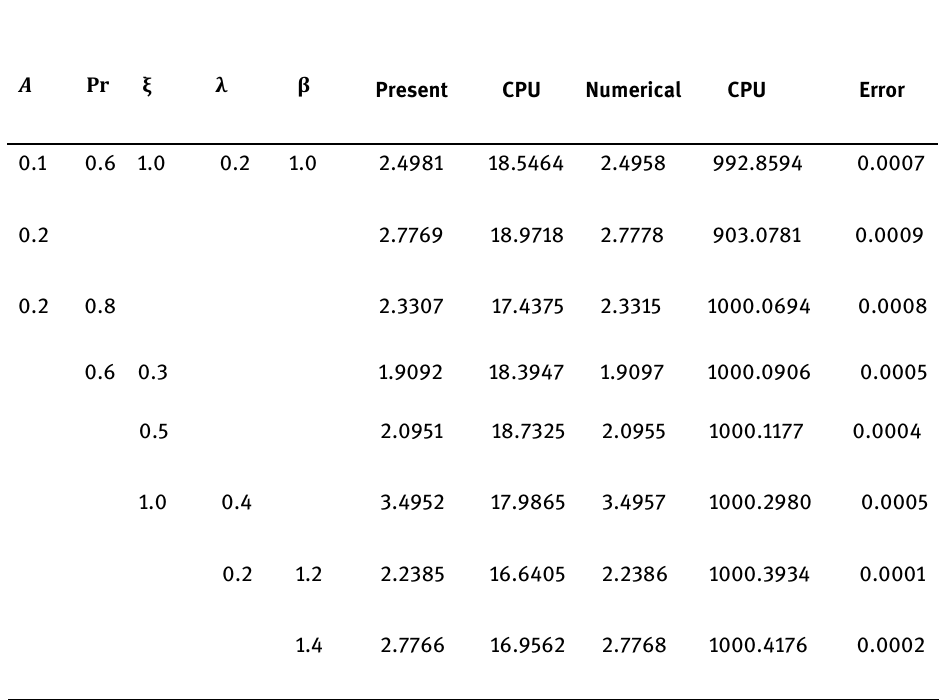
1 1/2 ) for different physical parameter values 2 C f Re